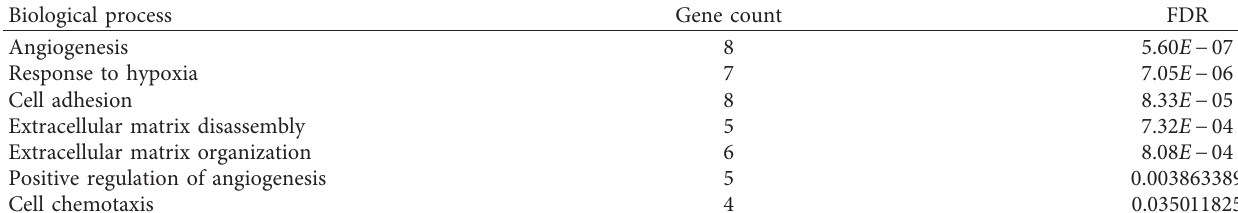
Table 1: Biological processes associated with hub genes in cluster 1.